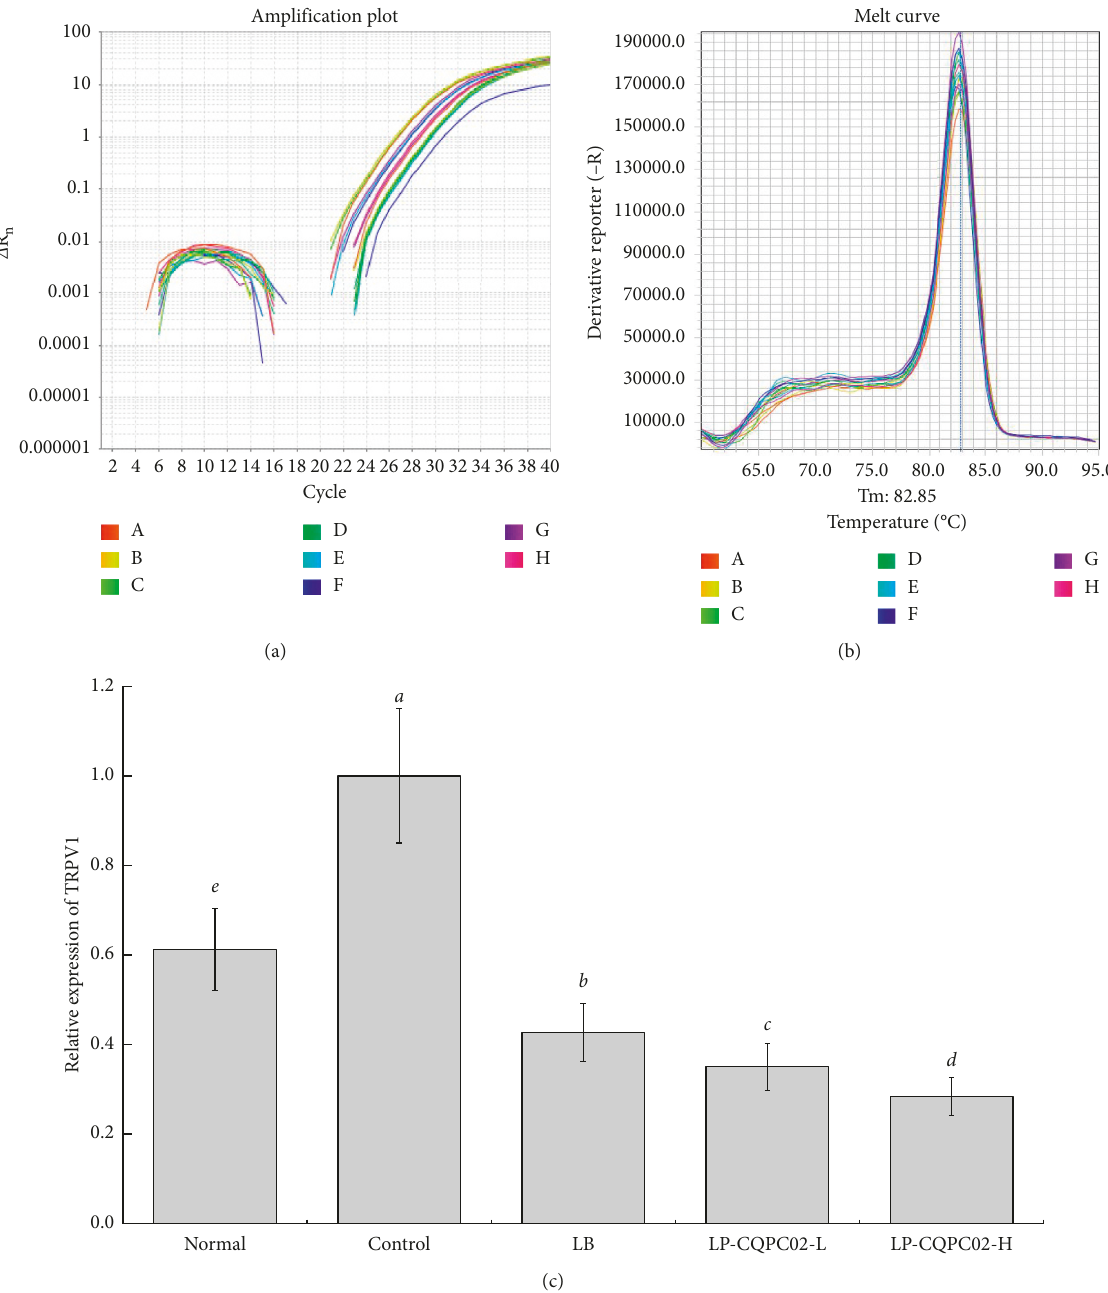
Figure 7: mRNA expression level of TRPV1 in the small intestine tissue of mice. (a) Amplification curve, (b) dissolution curve, and (c) relative expression. Values presented are the mean ± standard deviation. a–d The mean values with different letters in the same bars are significantly different ( p < 0.05) according to Duncan’s multiple-range test; there was no significant difference in the same letter repre- sentation between the two bars ( p > 0.05), but there was significant difference in the different letter representation ( p < 0.05). LB: Lactobacillus delbrueckii subsp. bulgaricus (1.0 × 10 9 CFU/kg b.w. gavage); LP-CQPC02-L: Lactobacillus plantarum CQPC02 (1.0 × 10 8 CFU/kg b.w. gavage); and LP-CQPC02-H: Lactobacillus plantarum CQPC02 (1.0 × 10 9 CFU/kg b.w.